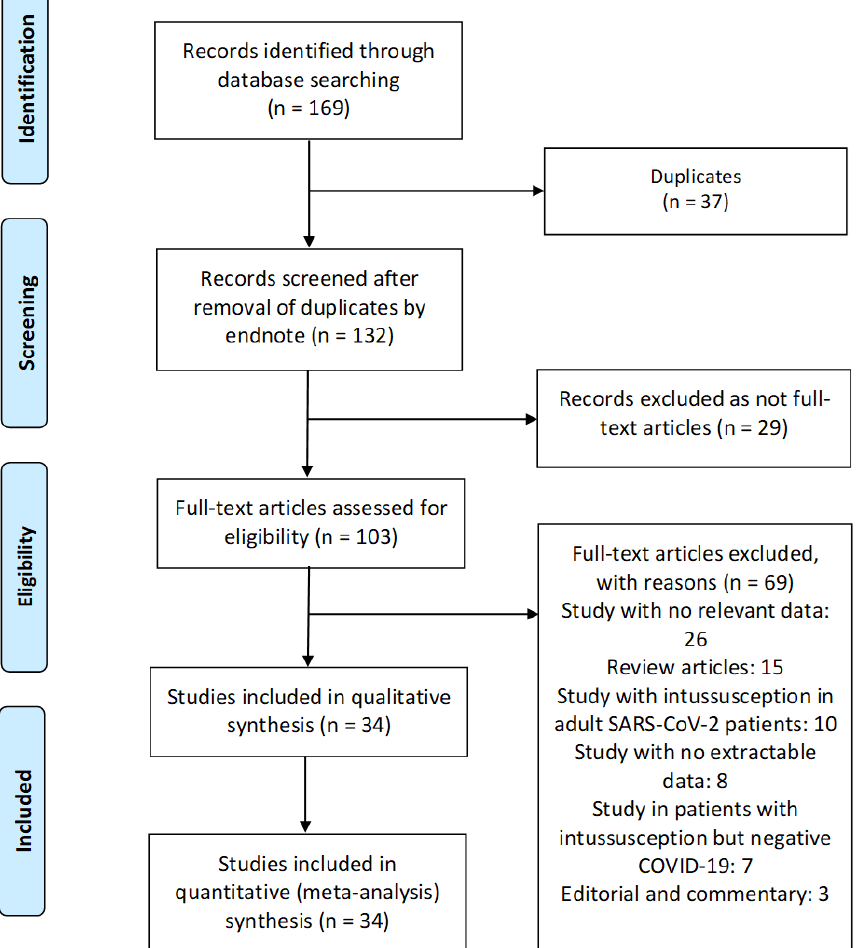
Figure 2. Flow diagram of the literature search and data extraction from studies included in the systematic review and meta-analysis.